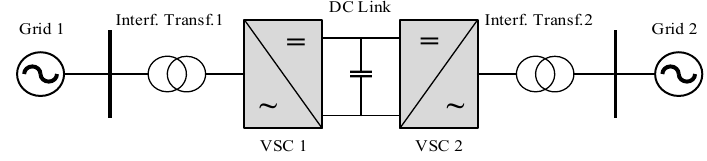
Figure 1. Back-to-back MVDC system topology.